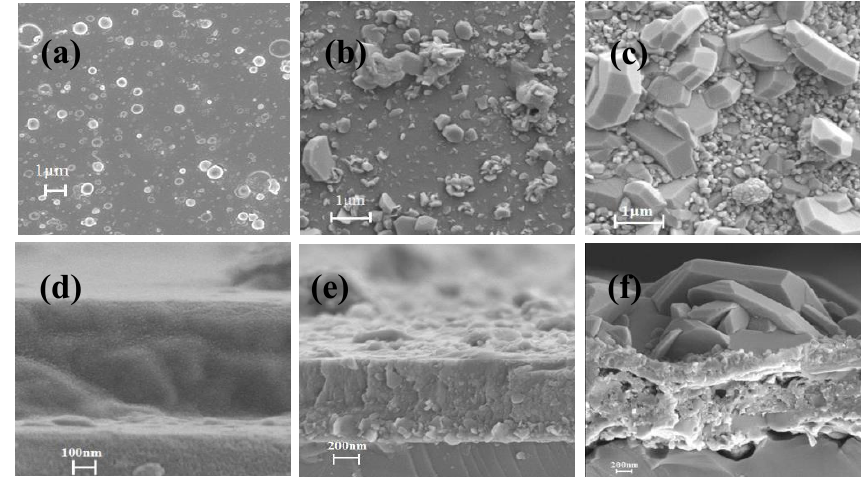
Figure 10. Surface ( a – c ) and cross-sectional ( d – f ) images of Cr–Si–N coatings before ( a , d ) and after oxidation at 800 °C ( b , d ) and 1200 °C ( c , f ).